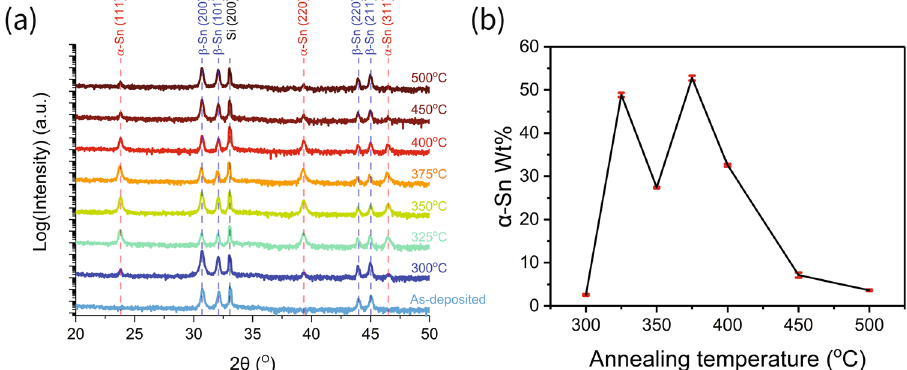
Fig. 3 XRD pattern analysis. a XRD patterns of as-deposited and annealed SnGe samples. The Si(200) peak from the single crystal substrate is due to multiple diffraction 60 . b Mass fraction of α -Sn versus annealing